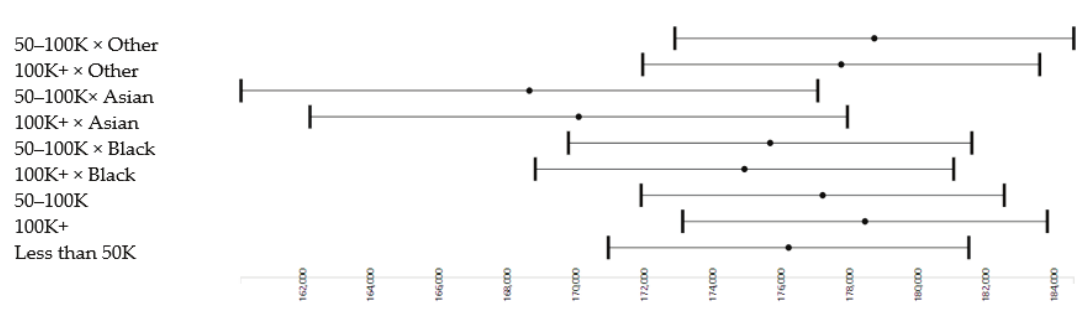
Figure 4. E ff ects of parental education on the whole-brain cortical surface area in the overall